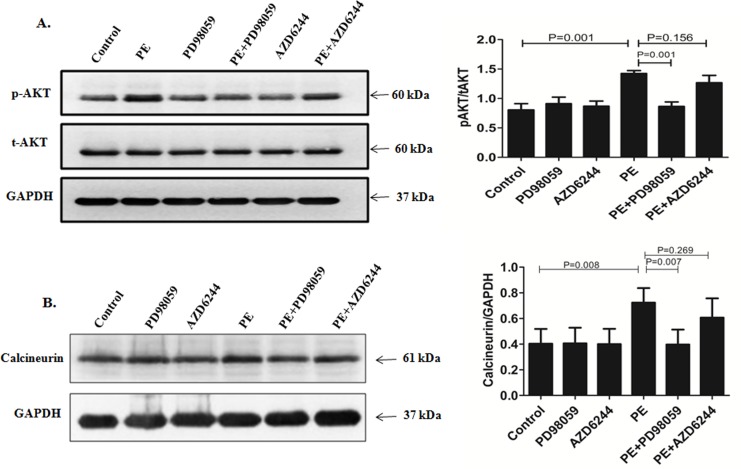
Unlike PD98059, there was no significant AKT activation and calcineurin block for Selumetinib.(A). Representative immunoblots using antibodies against phosphorylated AKT (pAKT) and total AKT (tAKT) to probe proteins extracted from NRCs for indicated treatments. The bar graph shows the means ± SEM signals of the pAKT/total AKT (relative expression from immunoblots of n = 3). (B). Representative immunoblots using antibodies against calcineurin. The bar graph shows the means ± SEM signals of the calcineurin/GAPDH (relative expression from immunoblots of n = 3).